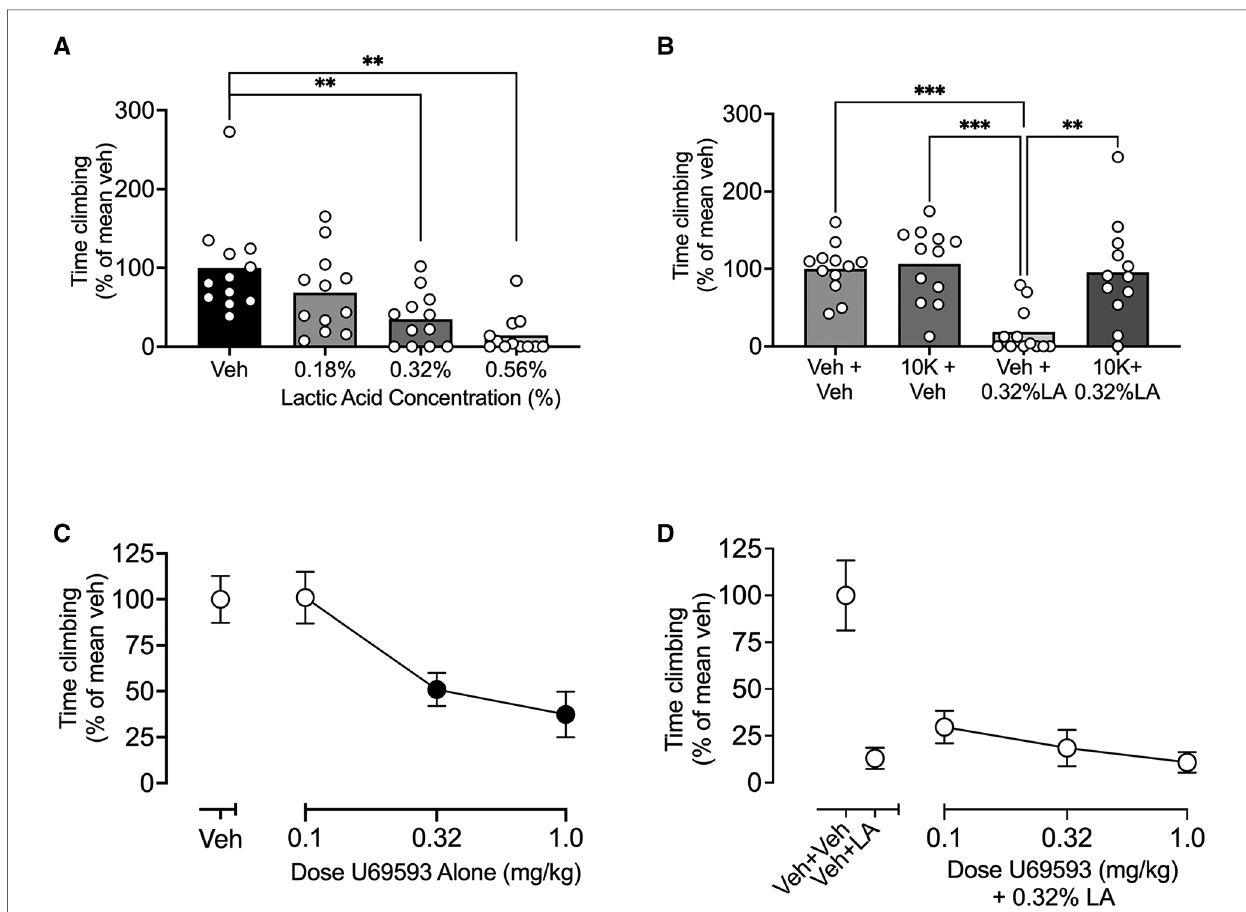
FIGURE 3 Effects of IP lactic acid, the positive control ketoprofen±IP acid, and the negative control U69593±IP acid on climbing. ( A ) IP lactic acid concentration- effect curve. Abscissa: Concentration of lactic acid diluted in sterile water for IP injection. ( B ) Effects of ketoprofen±IP acid. Abscissa: Treatment with SC saline or 10 mg/kg ketoprofen±IP water or 0.32% lactic acid. ( C ) Effects of the kappa opioid receptor agonist U69593 administered alone. Abscissa: U69593 dose in mg/kg. ( D ) Effects U69593 administered as a pretreatment to IP 0.32% lactic acid. Abscissa: Dose of the kappa opioid receptor agonist U69593 in mg/kg. For all panels, the ordinate is time climbing expressed as percentage of the mean climbing time after vehicle (Veh in A,C; Veh+Veh in B,D) in that group, and all bars and points show mean±SEM from 12 mice. Asterisks in panels A and B show a signi fi cant difference between treatments. ** P <0.01, *** P <0.001. Filled points in panel C indicate a signi fi cant difference from “ Veh ” , P <0.05. U69593 effects in panel D were compared to Veh+LA by one-way ANOVA (Veh+Veh data not included in analysis), and results were not signi fi